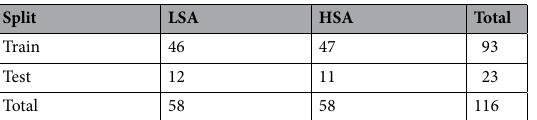
Table 3. Number of samples in each group and split of the experiment dataset. LSA low social anxiety group, HAS high social anxiety